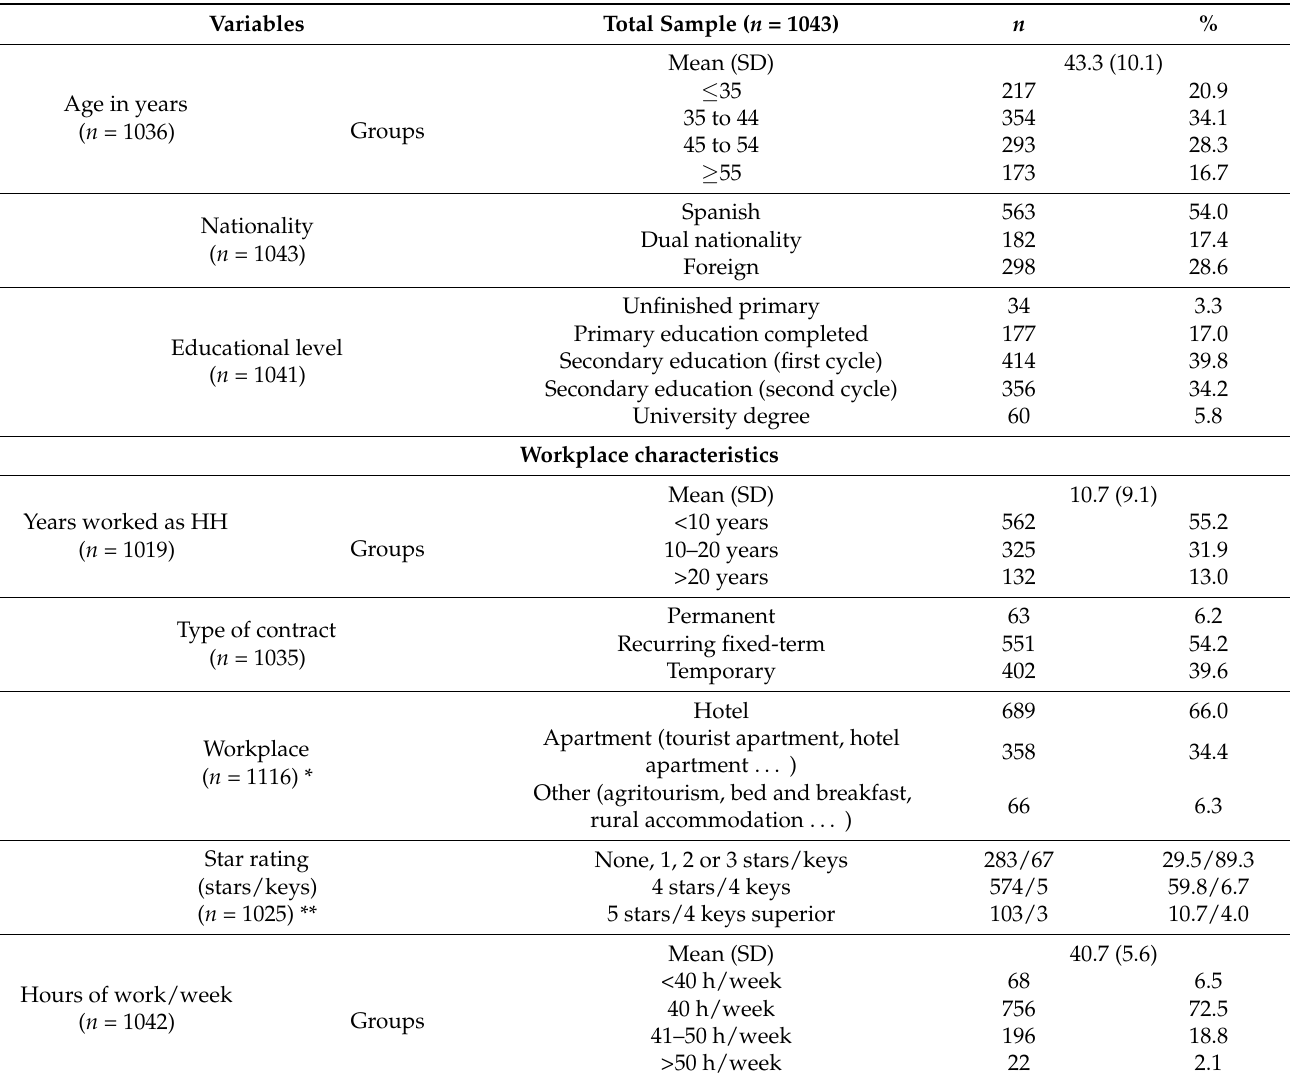
Table 1. Sociodemographic and occupational